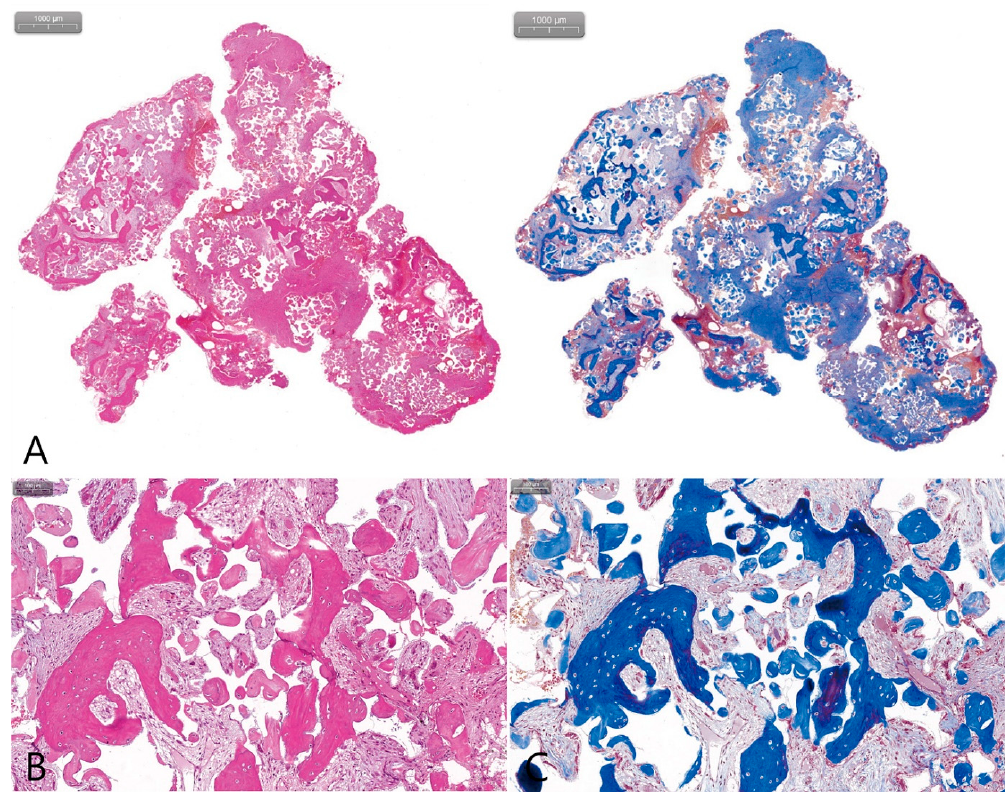
Figure 2. ( A ) Histopathological findings of the removed specimen (H-E stain, M-T stain); ( B ) there were many empty spaces between tissues, and no ciliary clumnar epithelium and inflammatory cells were found; loose connective tissue and woven bone were observed.